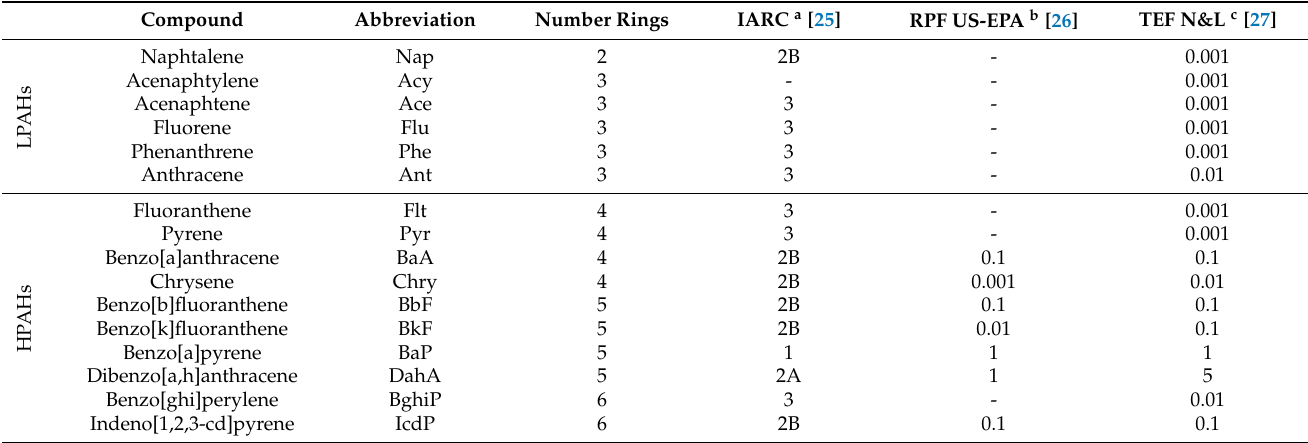
Table 2. List of Polycyclic Aromatic Hydrocarbons (PAHs), carcinogenicity classification, and toxicity